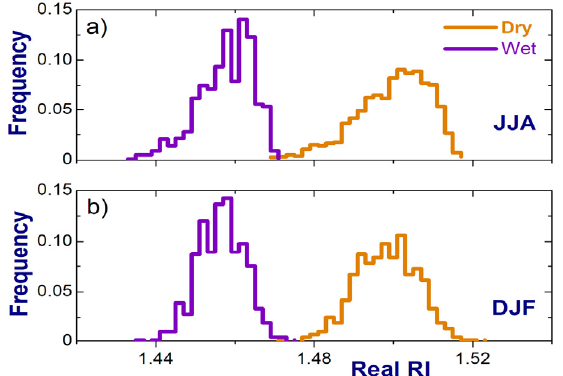
Figure 2. Normalized frequency of the real part of the complex RI obtained for dry and ambient conditions at 0.55 µ m wavelength from the near-surface chemical composition data collected during summer ( a ) and winter ( b ). Here, and below, abbreviations “JJA” and “DJF” stand for summer (June, July, August) and winter (December, January, February), respectively.